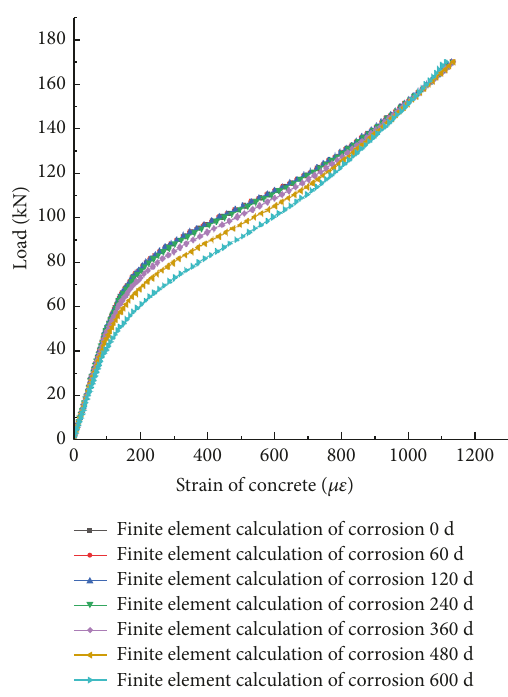
Figure 11: Load strain behavior of concrete at beam bottom.